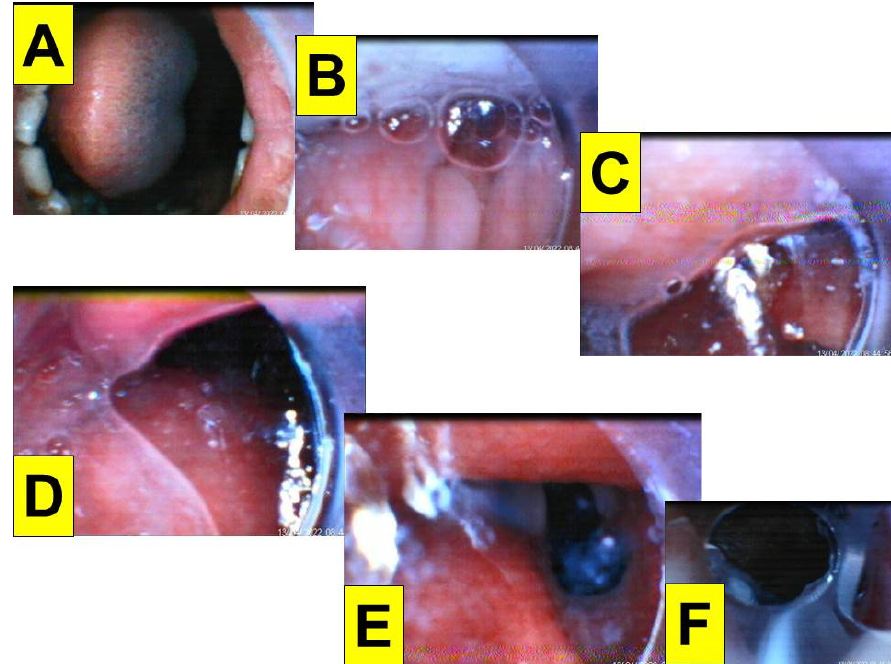
Figure 5. Various views displayed at the video monitor of the intubating stylet through a piece of plastic sheet barrier. ( A ) Entry of oral cavity; ( B ) partial view of tongue and oral space; ( C , D ) pharyngeal space and epiglottis; ( E ) glottic view with open vocal cords; ( F ) intra-tracheal space. The time for intubation (from lip to trachea) is 10 s. Copious saliva and bubbles, crowded pharyngeal space, and posteriorly displaced and relaxed epiglottis were noticed (see also the video clip in the Supplementary Materials Video S2).